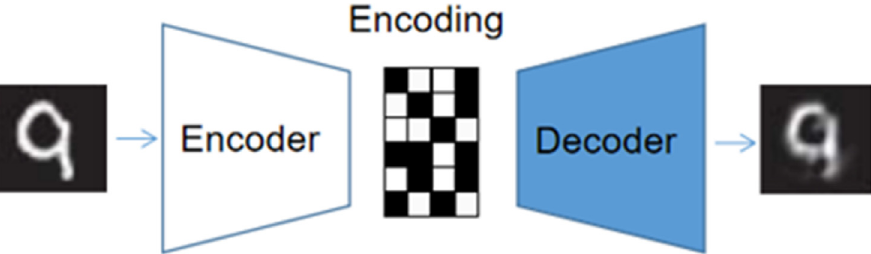
Fig. 3. AE is a special neural network architecture, and the input and output are the same architecture. It is trained in an unsupervised method to obtain the lower dimensional expression of the input data. These low-latitude information expressions are reconstructed back to high-dimensional data expressions.